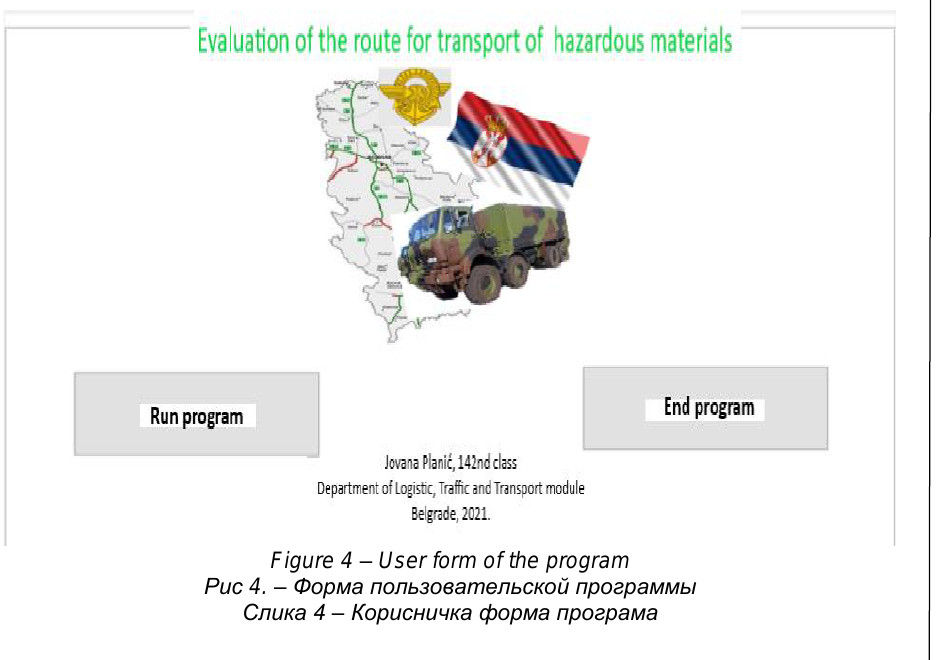
Figure 4 – User form of the program Рис 4. – Форма пользовательской программы Слика 4 – Корисничка форма